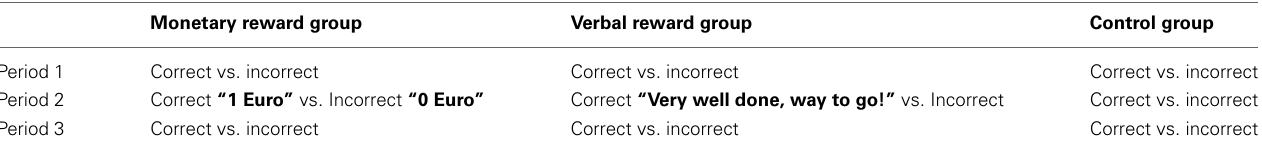
Table 1 | Feedback given in the different periods to the different groups of participants. Monetary reward group Verbal reward group Control group Correct vs.